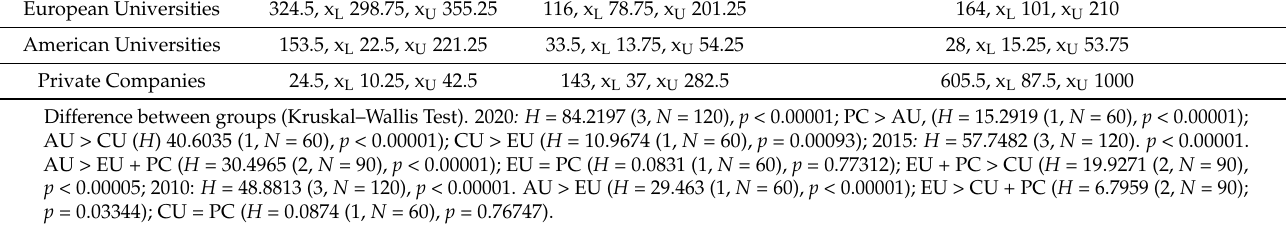
Table 6 . Trends within groups over time (Friedman test for repeated measures) in sub indicator “Innovation” in the best 30 universities of China, the European Union, the US, and in private companies. Group